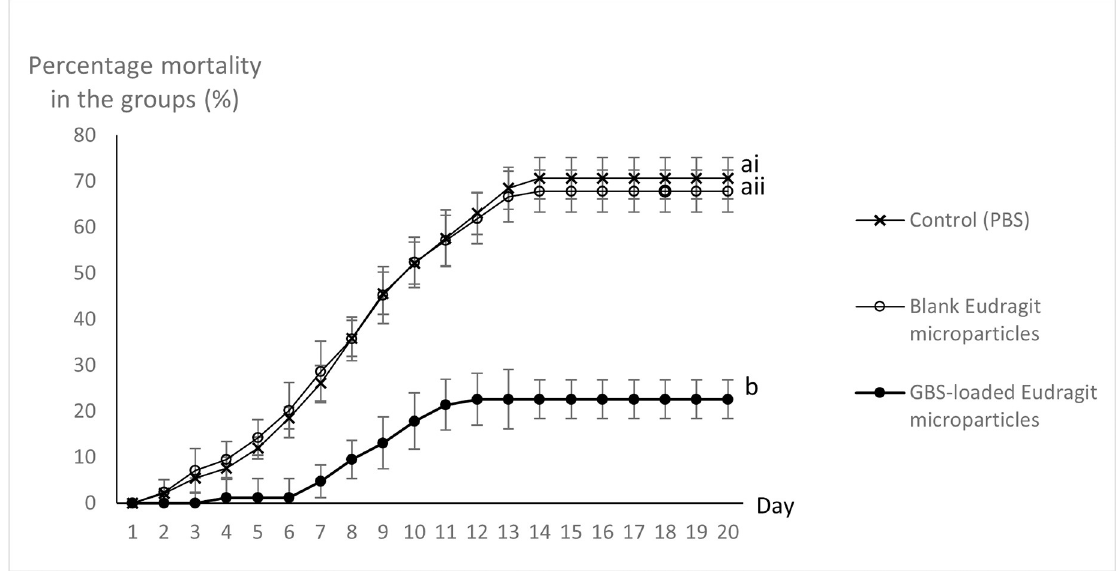
Fig 8. Cumulative percentage mortality in the 3 groups following oral gavage with: (ai) PBS in the negative control group; (aii) Blank Eudragit E100 microparticles; (b) GBS-loaded Eudragit E100 microparticles, and challenge by immersion using a homologous strain of Streptococus agalatiae sequence type 283 on day 21 post-gavage. Error bars represent SD from 4 replicate tanks (25 fish per tank) for each of 3 treatment groups.